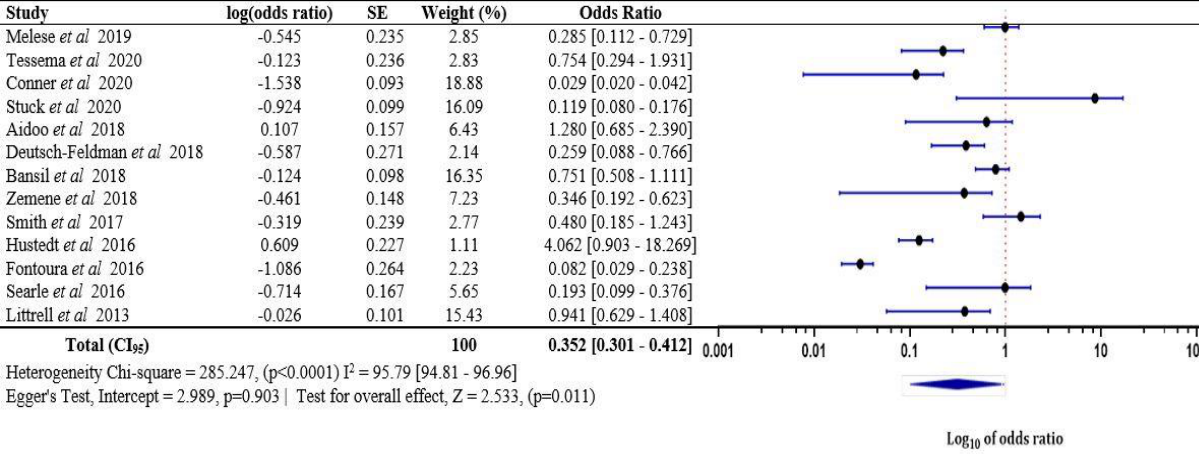
Figure 3. The risk of malaria infection in a neighbor of an index case compared with an index case household member [24,26,33,36–38,41,43,49,53,54,58,64]. SE: Standard Error, Log(odds ratio) values with “-“ are negative.